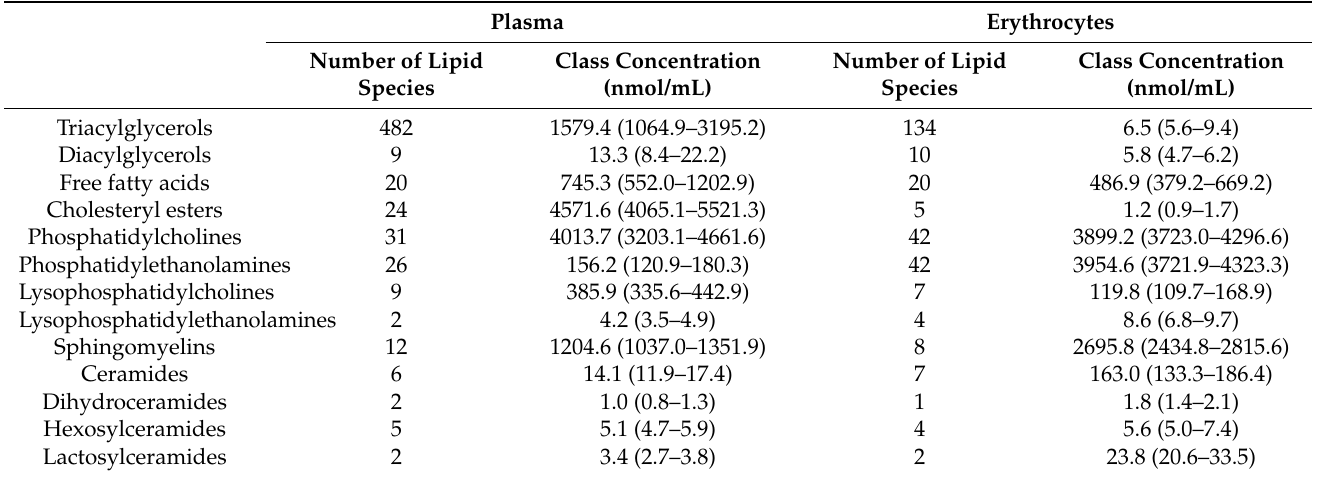
Table 1. Number of individual lipids per class and class concentrations in plasma and erythrocytes. Numbers represent median (interquartile range) unless otherwise specified. Data represent baseline